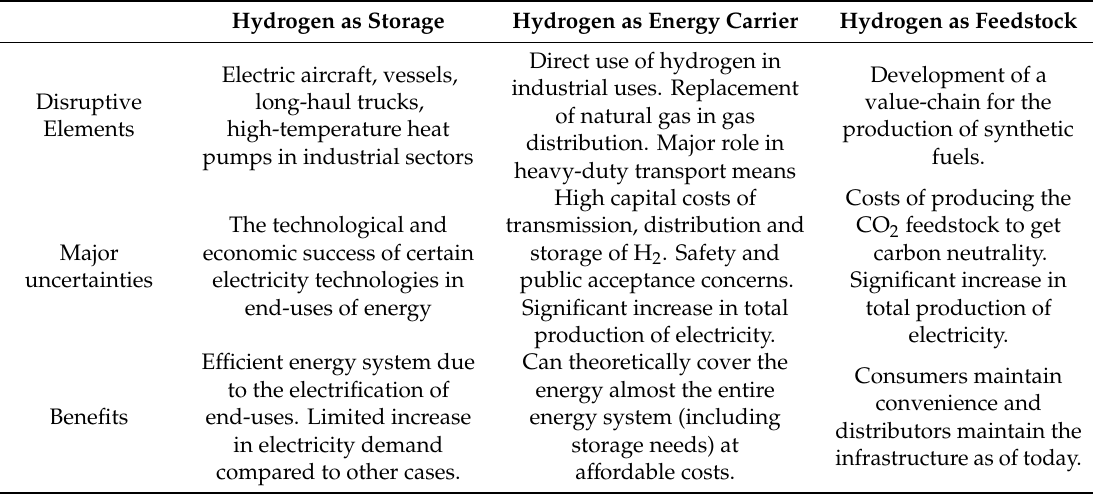
Table 2. Summary description of three stylized hydrogen